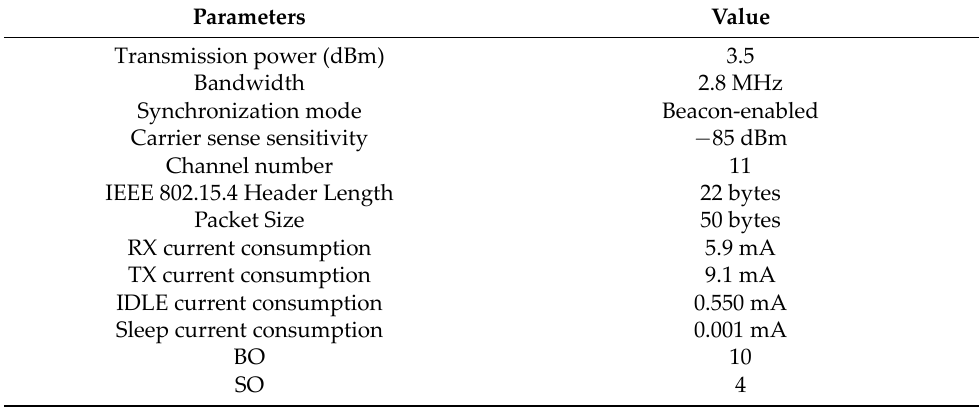
Table 1. Simulation